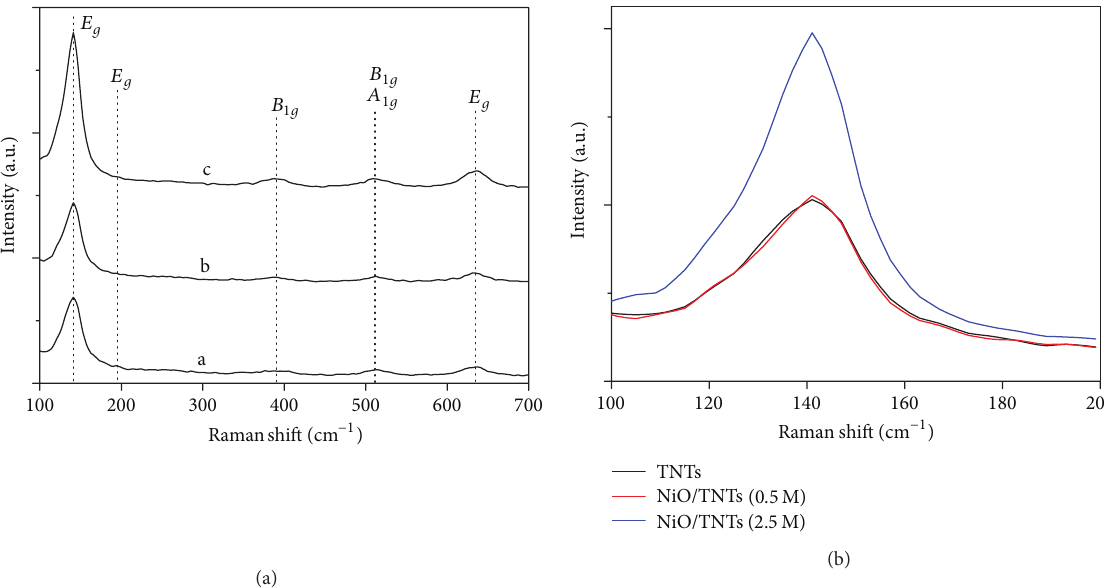
Figure 4: (a) Raman spectra of photocatalysts (a: TNTs; b: 0.5 M NiO/TNTs; c: 2.5 M NiO/TNTs) and (b) enlarged region of Raman shift range 100–200 cm −1 .